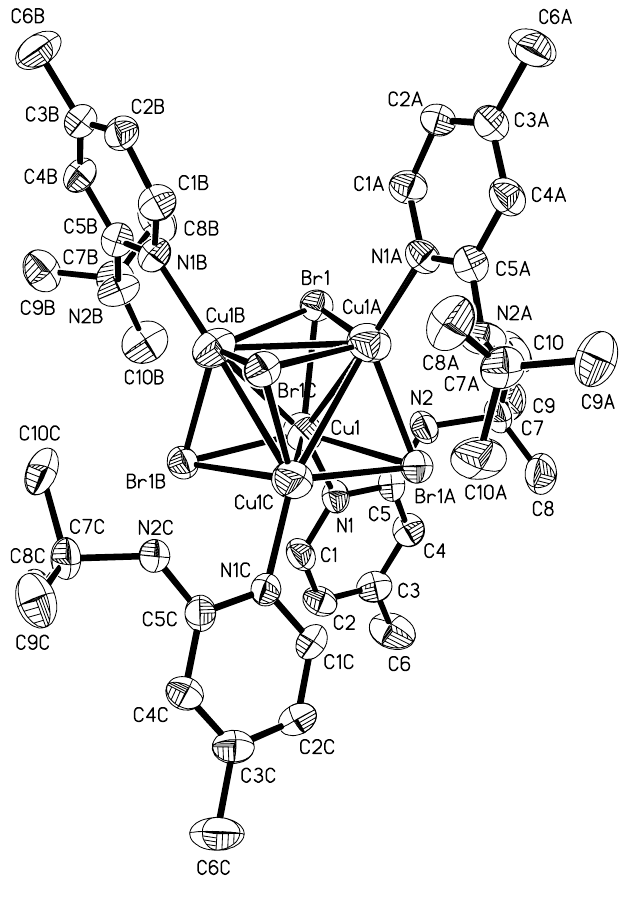
Table 2. Atomic coordinates and displacement parameters (in Å 2 )